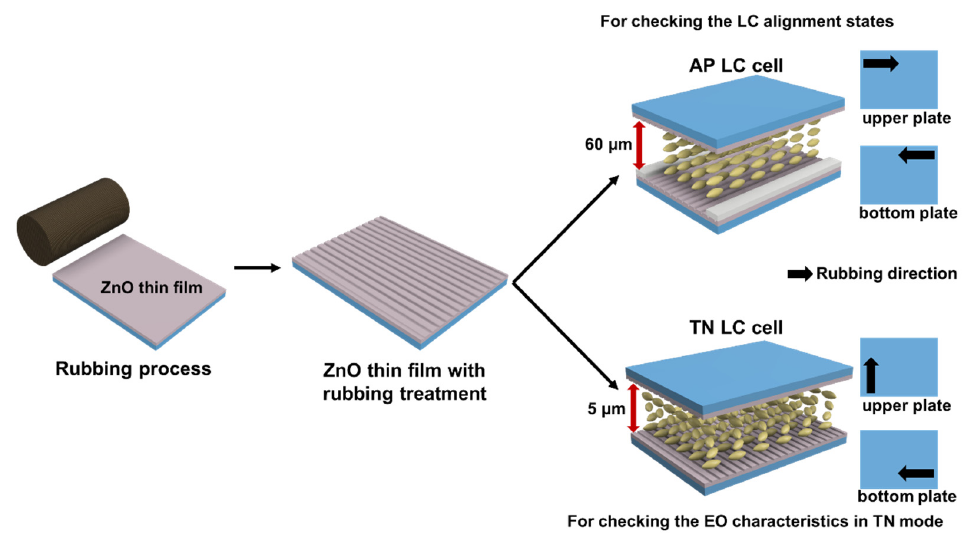
Figure 1. Schematic for fabricating the AP (anti-parallel) and TN (twisted-nematic) LC cell using the solution-derived ZnO films with rubbing treatment. AP LC cell and TN LC cell are to confirm the liquid crystal alignment state and electro-optical characteristics, respectively.